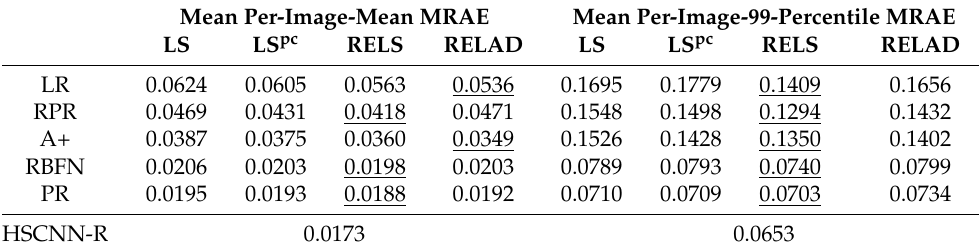
Table 3. The mean per-image-mean and per-image-99-percentile MRAE for all tested spectral reconstruction models. The result of HSCNN-R (the reference DNN model) is given in the last row. For all regression approaches (all except HSCNN-R), best results among the 4 training criteria—LS, LS pc , RELS, and RELAD—are underlined.